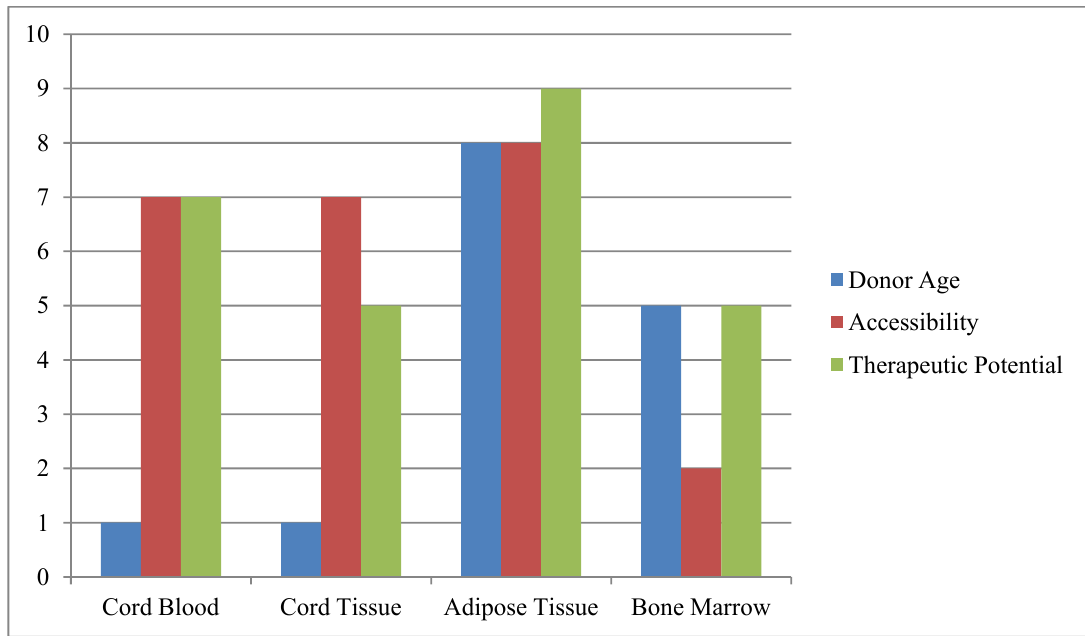
Figure 1. Schematic of Factors Impacting Stem Cell Banking. The most commonly available and practical sources of stem cells are compared versus one another for age at acquisition, ease of harvest (accessibility) and therapeutic potential. Donor age refers to total decades of life when one could acquire the stem cell sample; accessibility refers to how easy (10) or difficult (1) the stem cell sample is to collect; while therapeutic potential is used to indicate potential number of uses with (10) representing the greatest potential uses.